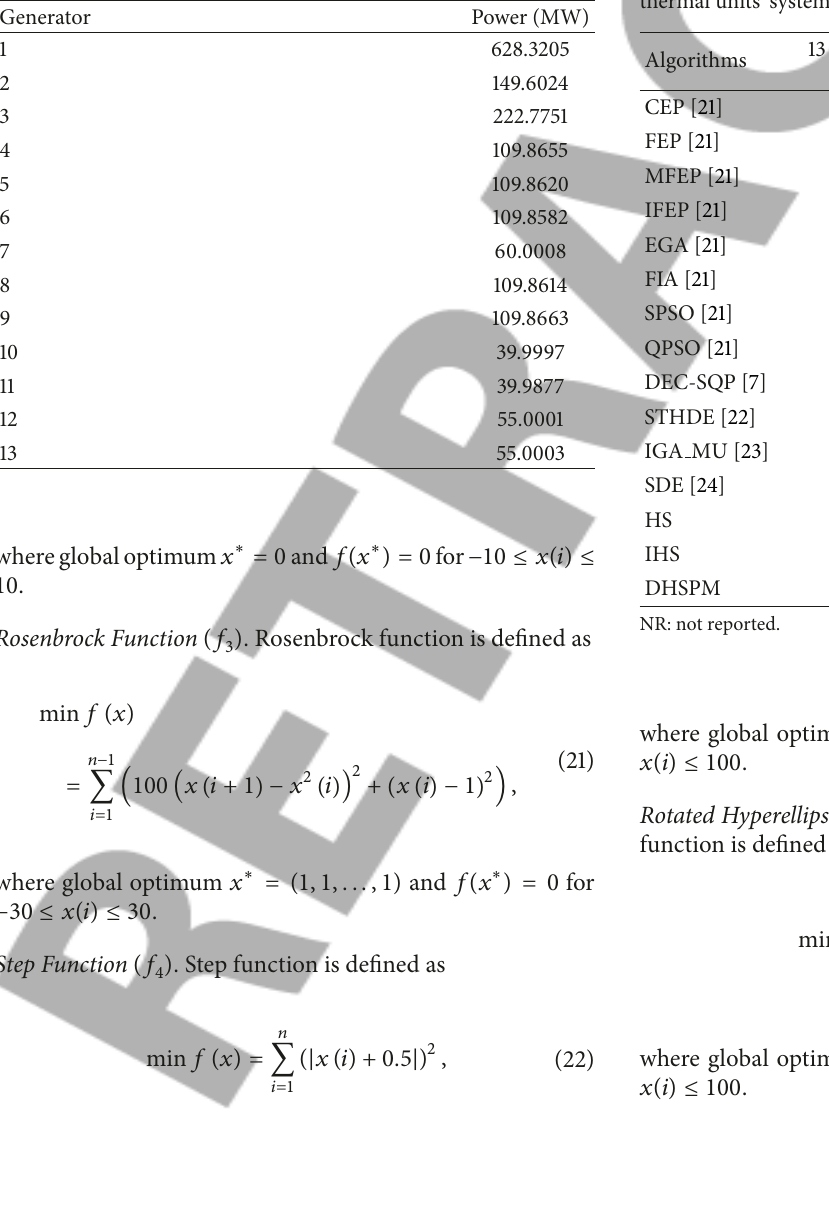
Table 7: 13 thermal units’ test results. Table 8: Best result comparison with different algorithms for